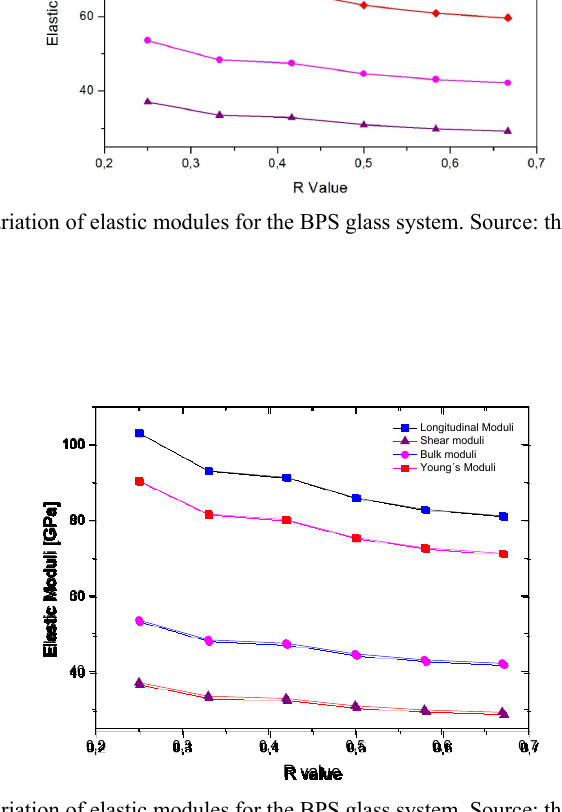
Figure 2. Variation of elastic modules for the BPS glass system. Source: the autors